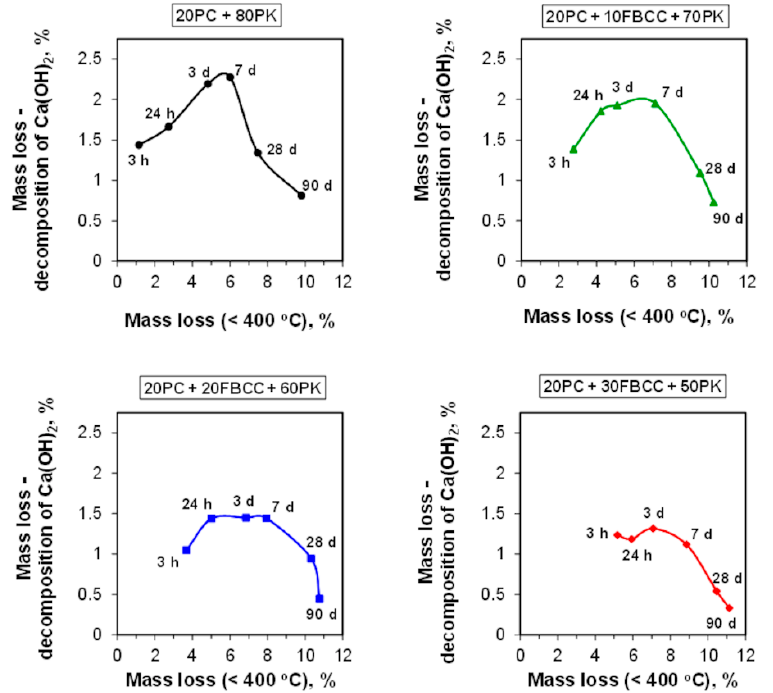
Figure 10. The dependence of the amount of water bound in hydrates and the mass loss resulting from the decomposition of Ca(OH) 2 .